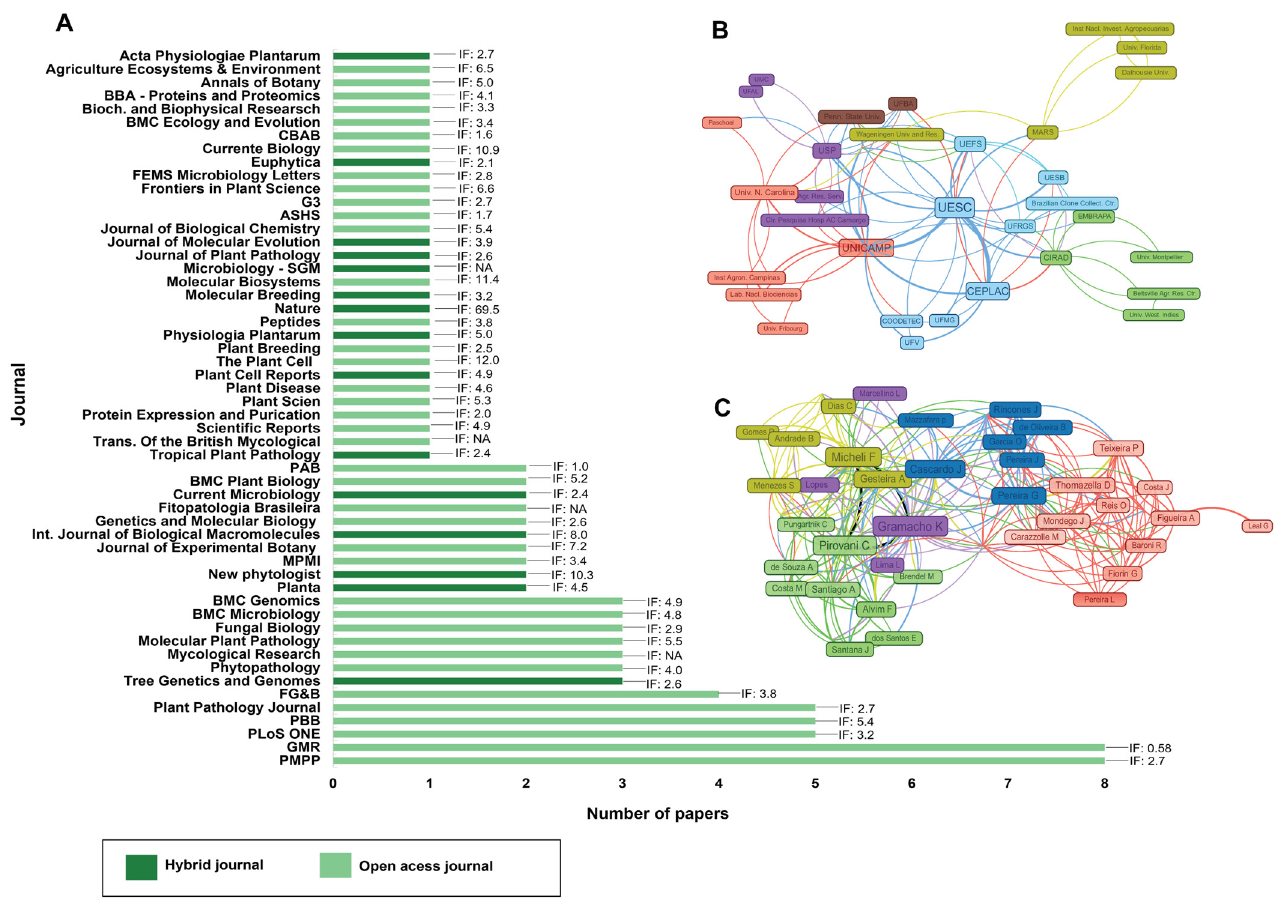
Figure 3. Production and dissemination of scientific knowledge on the molecular biology of M. perniciosa and its hosts: ( A ) distribution of studies by journal; ( B ) collaboration network among the authors’ research institutions; and ( C ) collaboration network among authors. Nodes with the same colors in figures ( B ) and ( C ) represent, respectively, institutions and authors grouped by similarity by the Vosviewer software (version 1.16.17). The font sizes of the captions are proportional to the number of publications with participation of institutions and authors. The journals’ impact factors were taken from their own websites in August 2022. IF = Impact